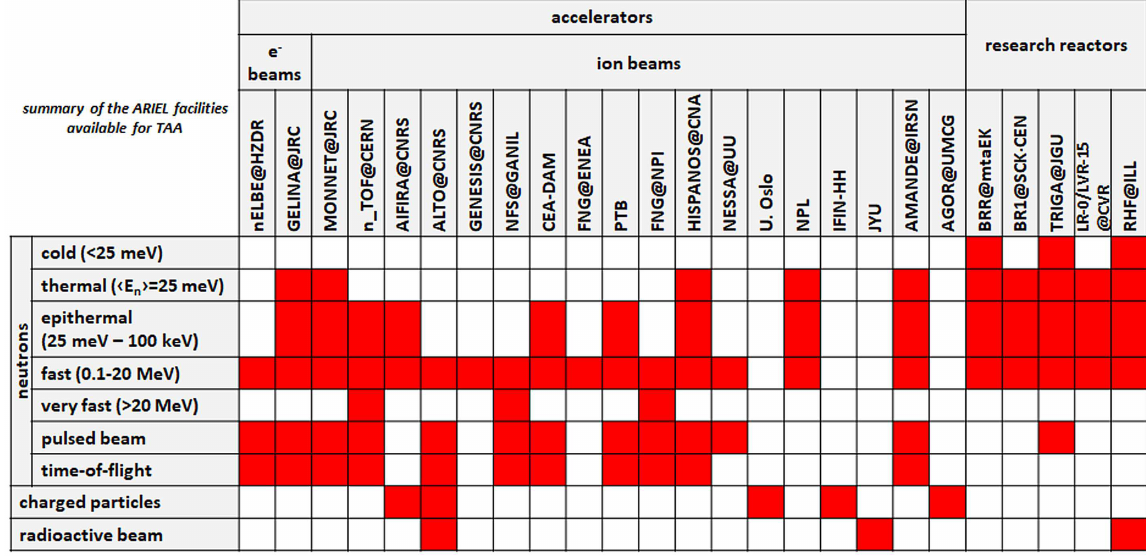
Fig. 1. Neutron and ion beams available at the ARIEL research